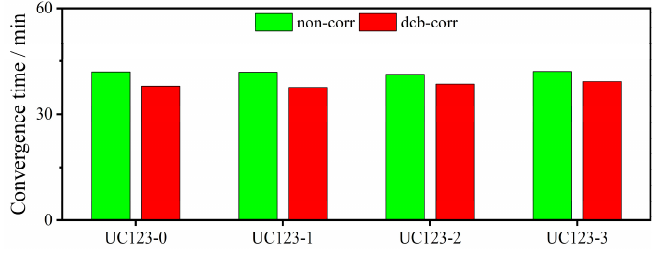
Figure 11. Average convergence time of UC123.